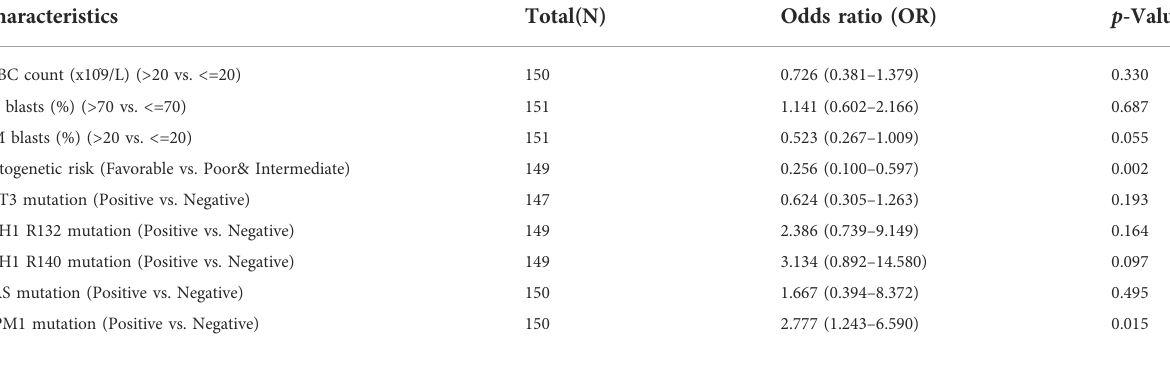
TABLE 2 The relationship between the clinicopathological factors of LAML and B4GALT1 expression was determined by the logistic analysis.